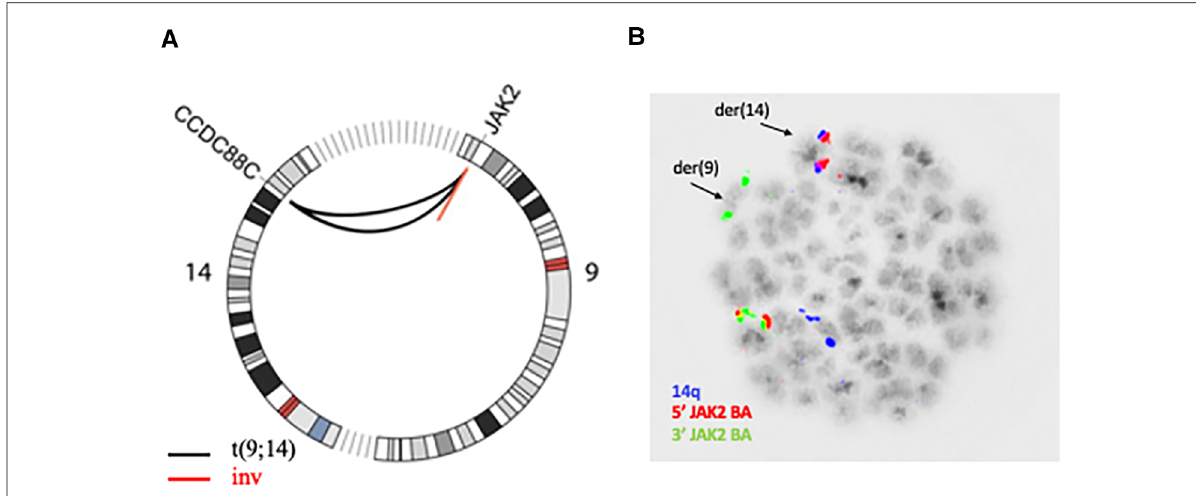
FIGURE 1 ( A ) Circos plot showing chromosomes 9 and 14; the black lines represent the reciprocal translocation together with the concomitant inversion of the small fragment from 9p23.1 (red line). ( B ) Aberrant metaphase hybridized with JAK2 break apart probe (red/green signal, CytoTest) and 14 centromere probe (blue signal) showing the distal red signal (5 ′ end) of JAK2 translocated to